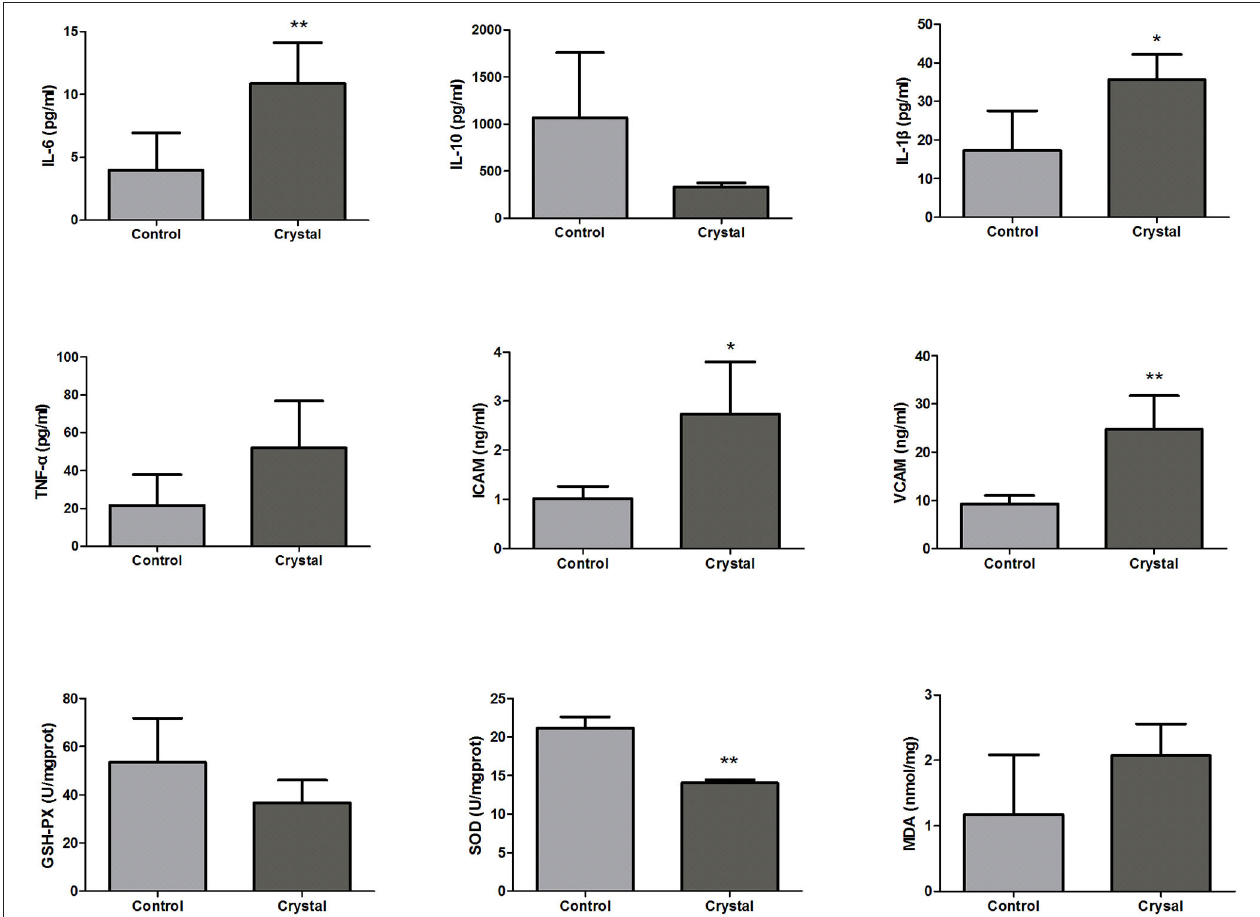
FIGURE 5 | The levels or activities of Interleukin-6 (Il-6), Interleukin-10 (Il-10), Interleukin-1 β (Il-1 β ), tumor necrosis factor- α (Tnf- α ), intercellular cell adhesion molecule (Icam), vascular cell adhesion molecule (Vcam), glutathione peroxidase (GSH-Px), superoxide dismutase (Sod), and malondialdehyde (MDA) in renal tissues of the Control group and Crystal group ( n = 5). * p < 0.05 compared with the Control group, ** p < 0.01 compared with the Control group.